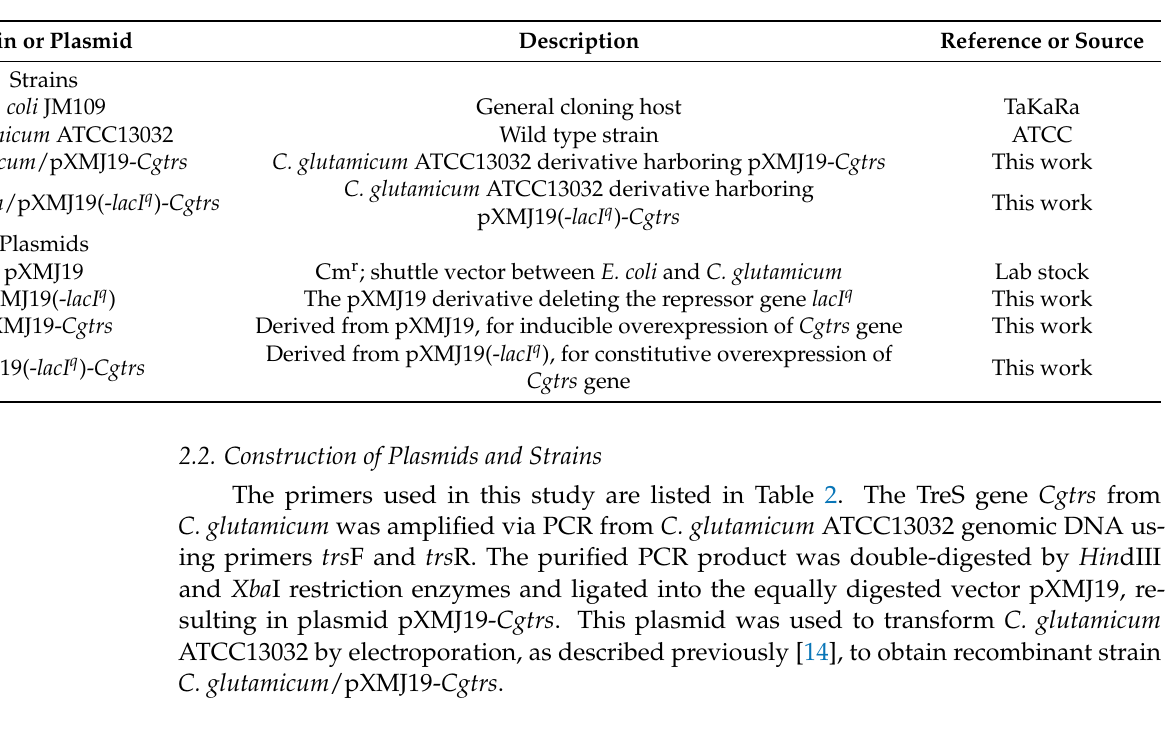
Table 1. Strains and plasmids used in this study.